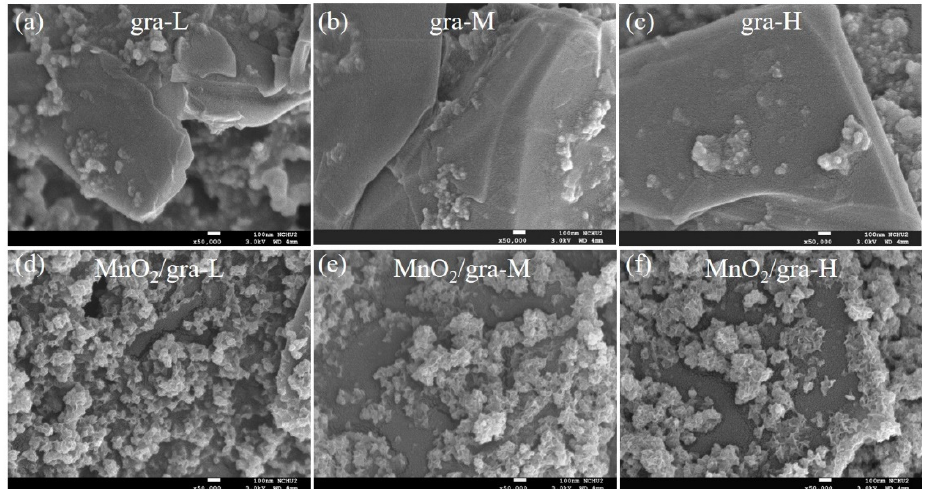
Figure 2. FESEM of ( a ) gra-L, ( b ) gra-M, ( c ) gra-H, ( d ) MnO 2 /gra-L, ( e ) MnO 2 /gra-M, and ( f ) MnO 2 /gra-H.